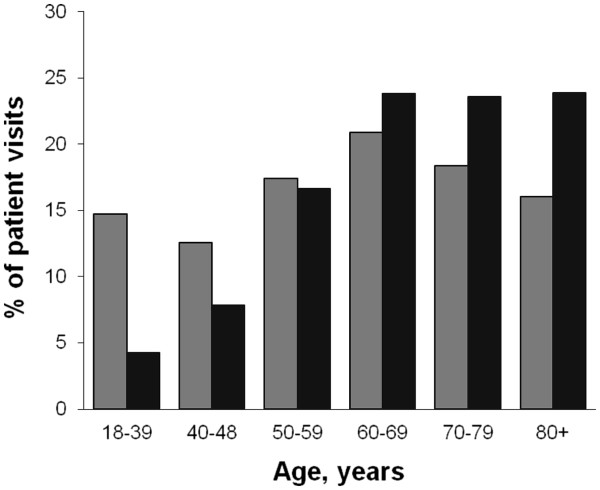
Age distribution among all included patients, (gray square) and patients admitted for in-hospital care (black square).